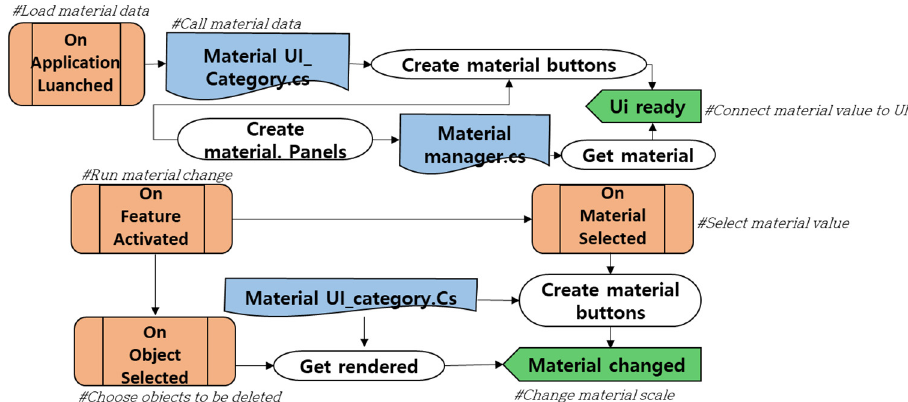
Figure 13. Algorithm for development of material change function.